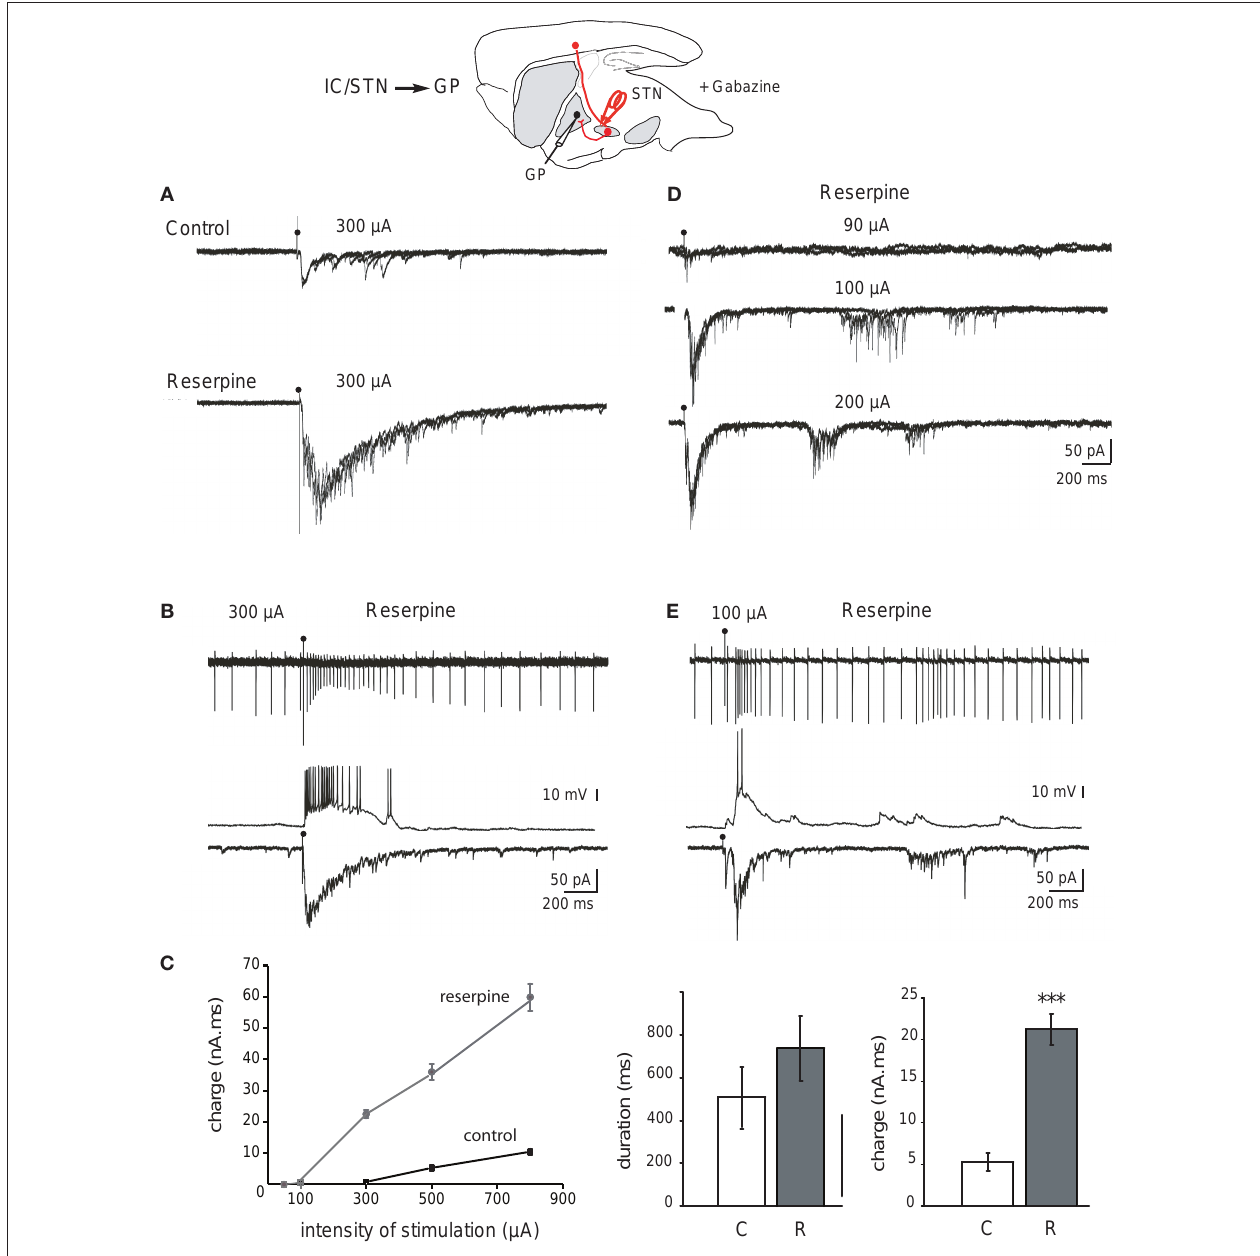
Figure 2 | response of gP neurons to stimulation of the internal capsule or rostral STN in control and dopamine-depleted BgS. Top: Schematic illustration of the experimental design with the stimulation (red) and recording sites. (A) Example traces from GP cells recorded from control BGS (top) and BGS from a reserpinized mouse (bottom). A single shock (100 μs, 300 μA) was delivered with the same stimulating electrode to the rostral pole of the STN at the time of the artifact. It evoked compound glutamatergic EPSCs ( V = − 70 mV, three superimposed traces). (B) Recordings from the same GP H neuron in cell-attached current clamp mode (top), whole-cell current clamp mode (middle, V = − 60 mV) and whole-cell voltage clamp mode (bottom, m